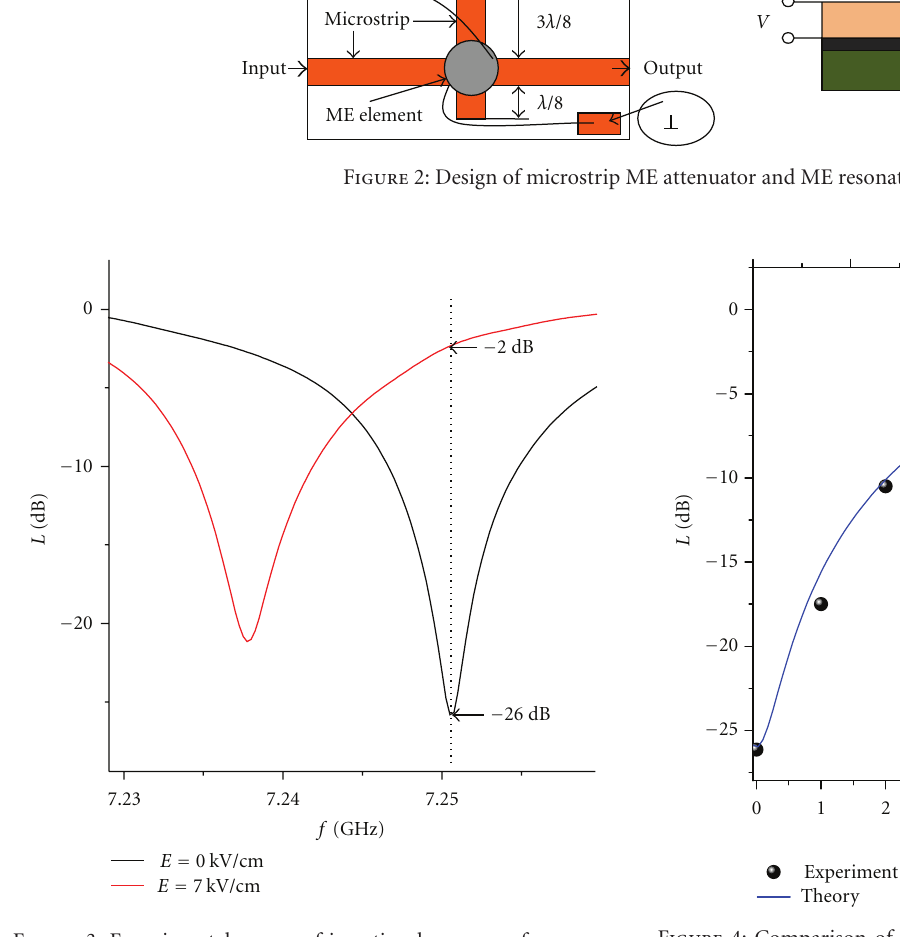
Figure 4: Comparison of experimental and theoretical data. YIG [111] thickness is 110 μ m; diameter is 2,5 mm; PMN-PT tickness is 0,5mm; diameter is 6 mm. Field H = 1910 Oe; field is parallel to plane of sample; average is 30; central frequency is 7251